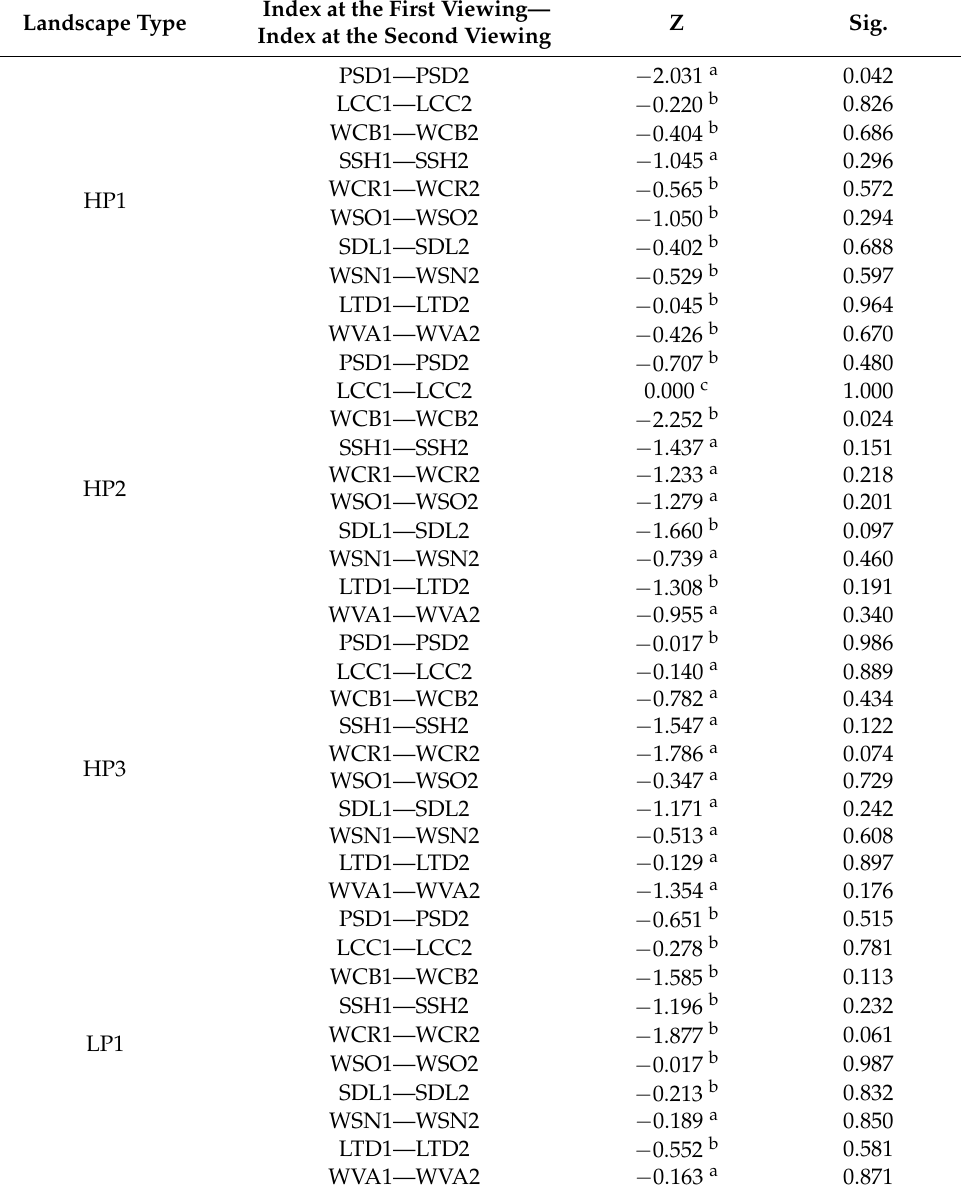
Table A1. Analysis of the difference in cognitive evaluation indexes between the first viewing and the second